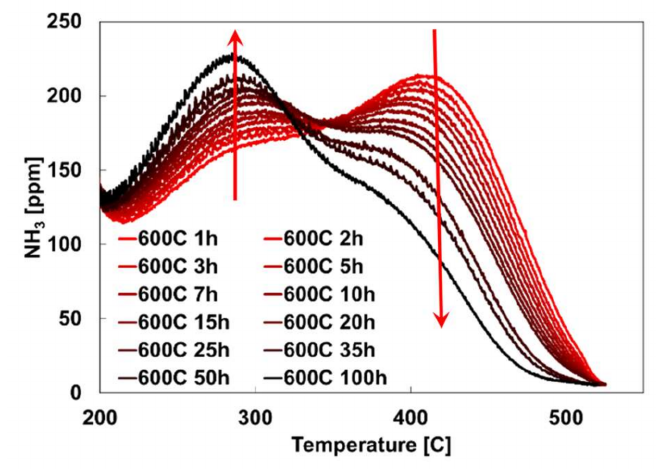
Figure 5. NH 3 -TPD profiles for Cu/SSZ-13 upon progressive aging at 600 ◦ C; arrows indicate increasing aging times. Reprinted from J. Catal. , 2017 , 348 , 291–299. Copyright 2017, with permission from